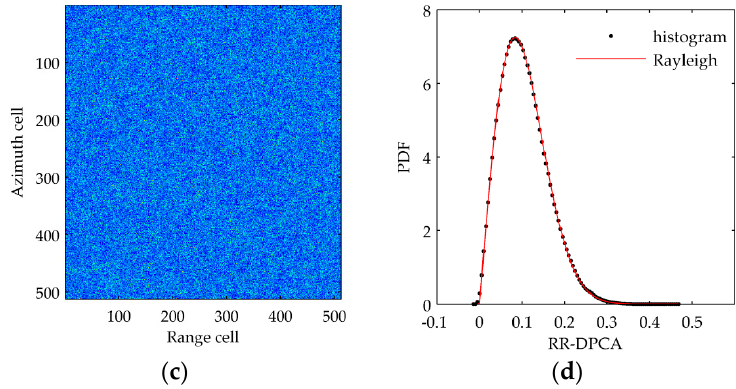
Figure 1. Clutter statistical distribution analysis. ( a ) 1th channel clutter image; ( b ) Interferogram amplitude and phase; ( c ) RR-DPCA image; ( d ) RR-DPCA amplitude histogram. Table 1. Theoretical and measured mean value and variance.